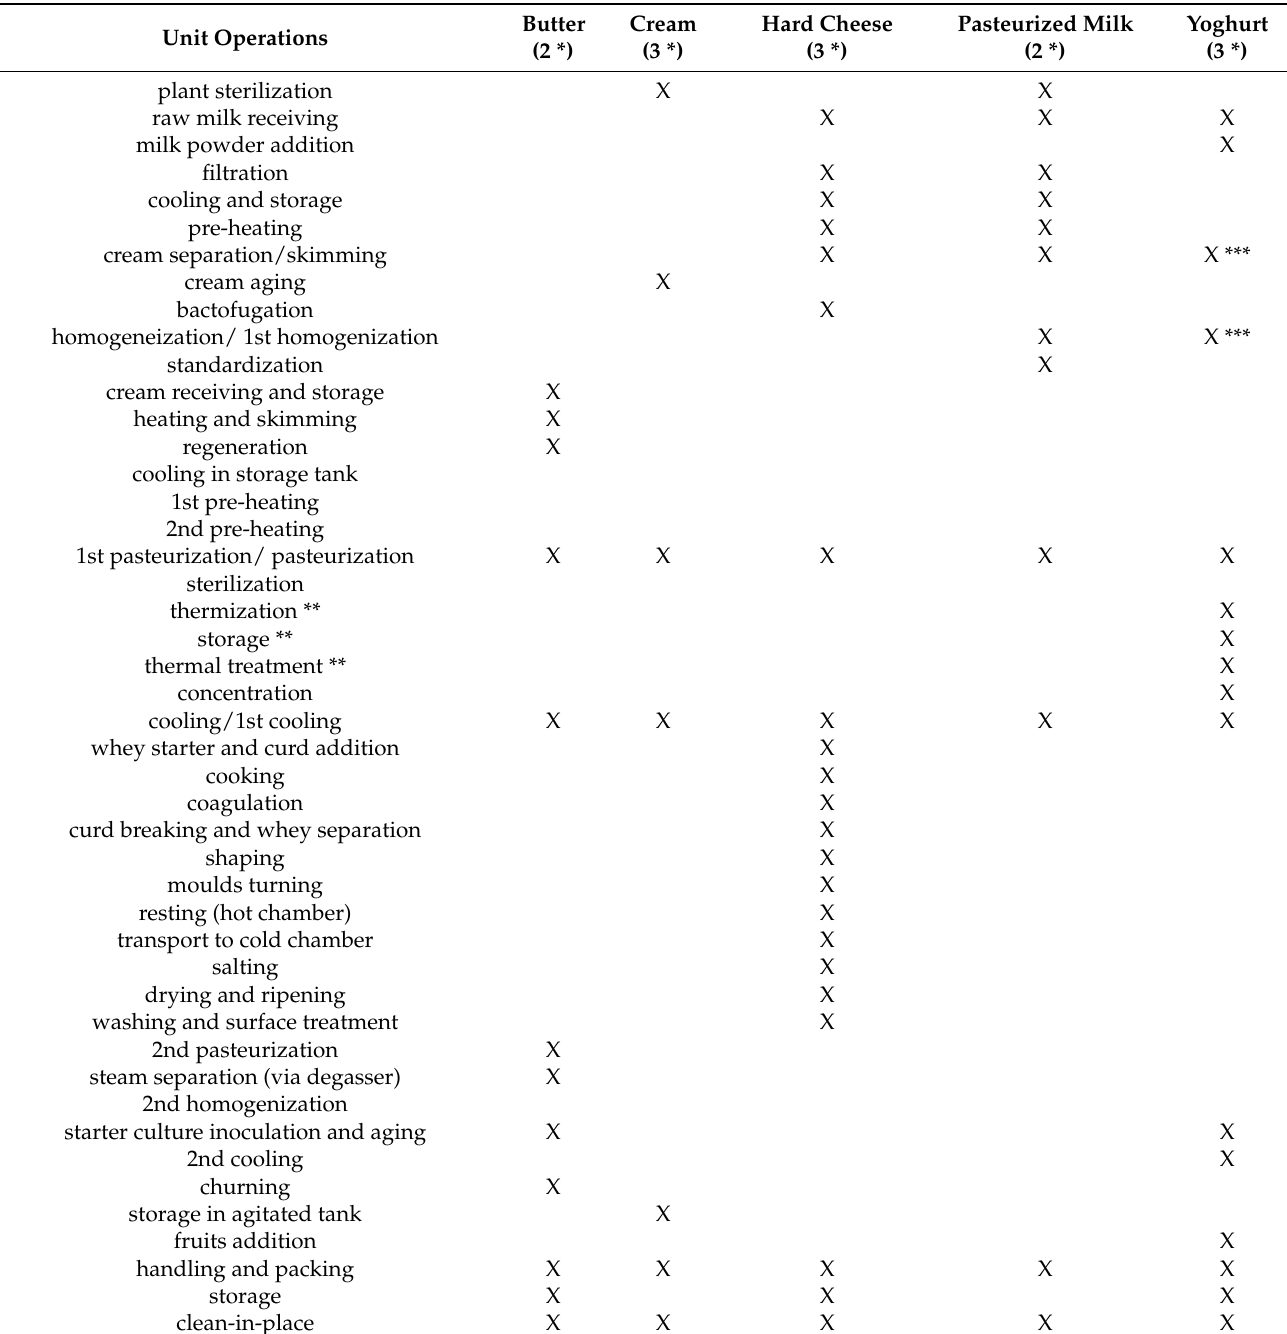
Table 2. Unit operations involved in manufacturing of some dairy products according to the analysis of energy audits of dairy